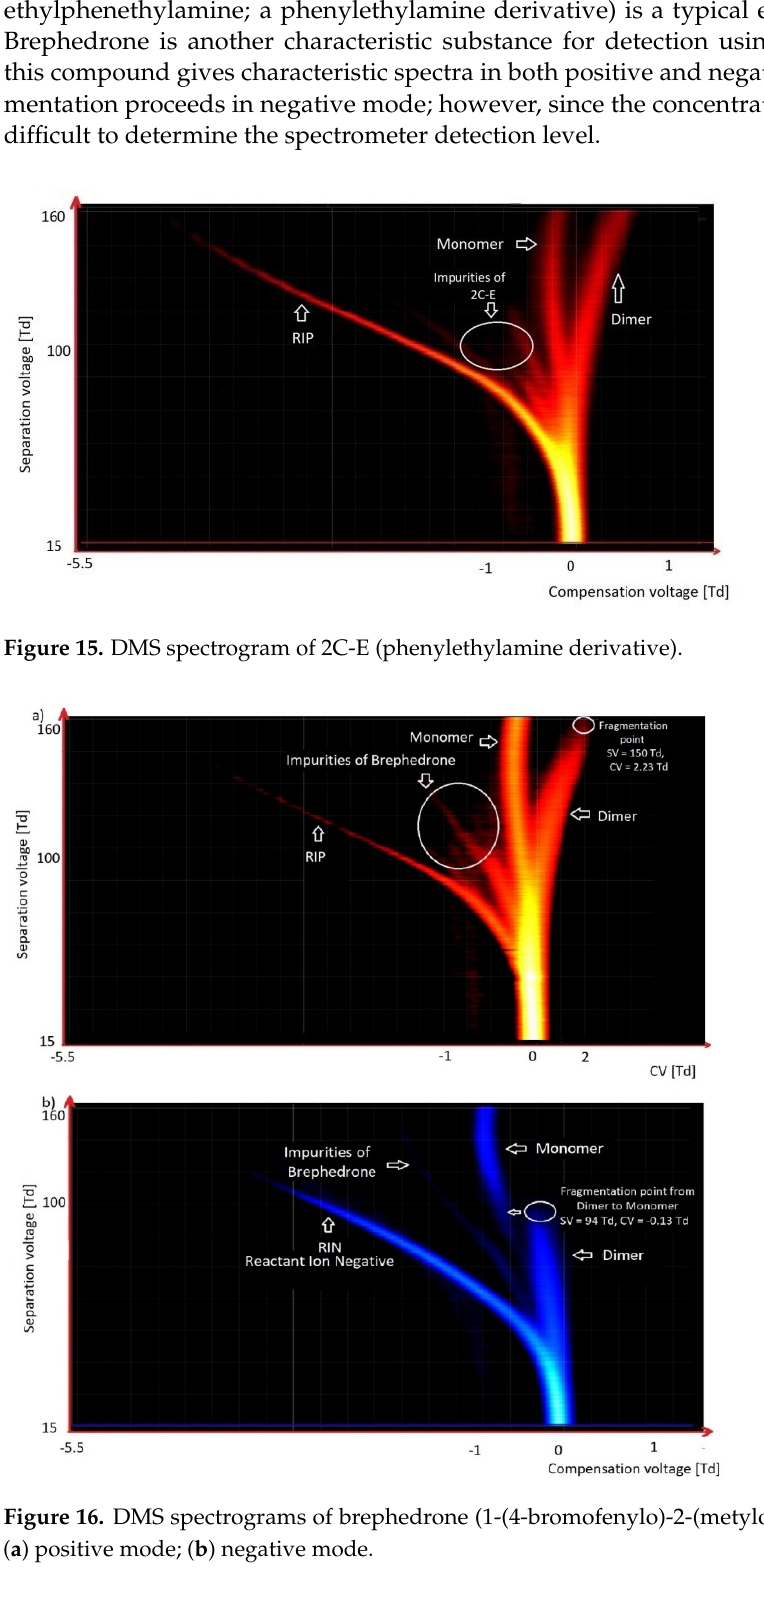
Figure 16. DMS spectrograms of brephedrone ( 1-(4-bromofenylo)-2-(metyloamino)-propan-1-on): ( a ) positive mode; ( b ) negative mode.